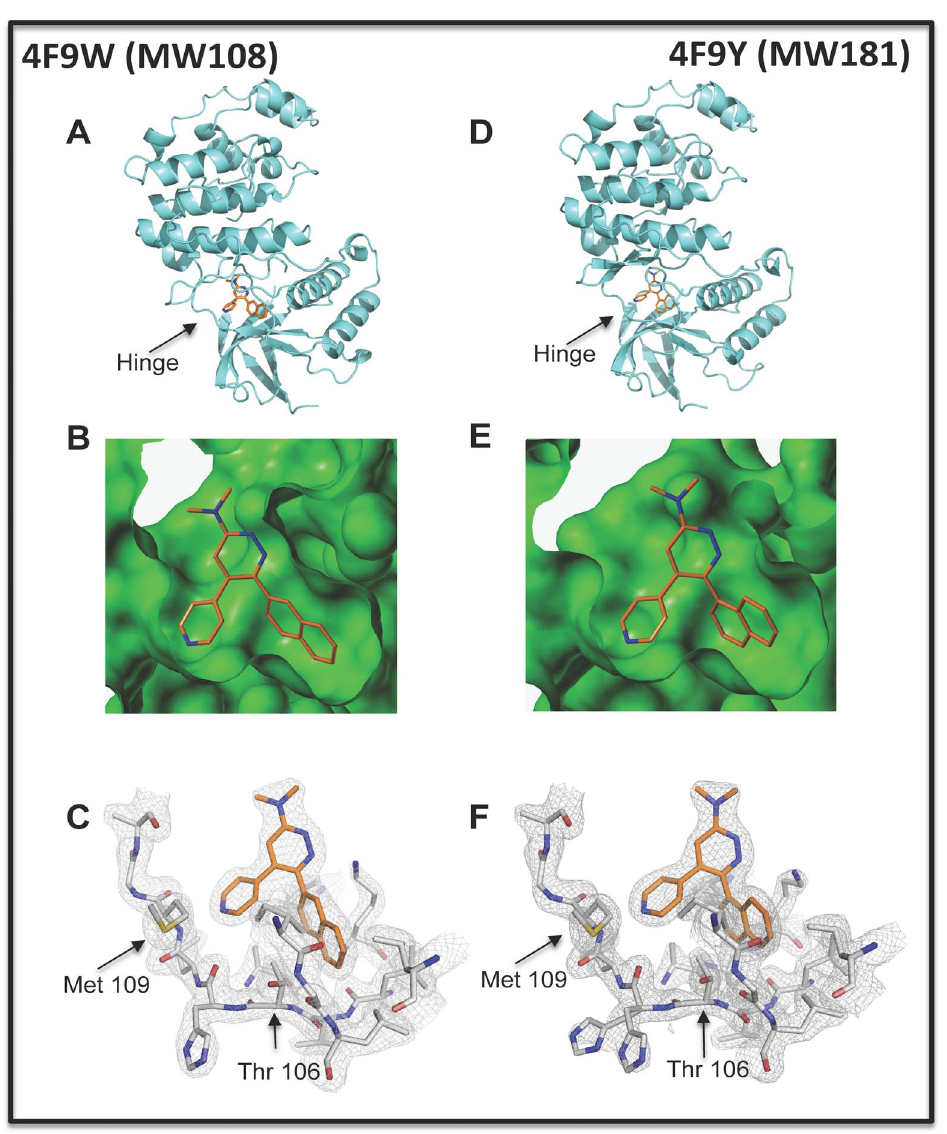
Figure 4. Crystal structures of human p38 a MAPK with MW108 (PDB 4F9W) or MW181 (PDB 4F9Y) bound in the active site. A. The 2.00A˚ structure (4F9W) of human p38 a MAPK (cyan ribbons) containing MW108 (colored by atom type) bound in the active site is shown. The typical kinase bi-lobed nature is evident, with the hinge region connecting the two lobes of the kinase indicated by the arrow. B. A Connolly surface generated from the coordinates of 4F9W highlights the complementary features between MW108 and the kinase active site. C. Electron density map (2mFo-Dfc) for 4F9W contoured at a 1.5 rmsd level. The diffraction data clearly reveals the inhibitor presence in the active site. The relative positions of Met 109 in the hinge region and the hydrophobic pocket’s small gatekeeper residue Thr 106 are indicated by arrows. The pyridine ring nitrogen of MW108 makes H-bond interactions with the protein backbone at the Met109-Gly110 peptide bond. D. The 1.85A˚ resolution structure (4F9Y) of human p38 a MAPK (cyan ribbons) with MW181 (colored by atom type) bound in the active site is shown, with the hinge region indicated by the arrow. E. A Connolly surface generated from the coordinates of 4F9Y highlights the complementary features between MW181 and the kinase active site. F. Electron density map (2mF0-Dfc) for 4F9Y contoured at 1.5 rmsd. The difference in orientation of the1-naphthyl substituent in MW181 4F9Y from that of the 2-naphthyl substituent in MW108 4F9W (Panel C) is evident from the diffraction data.